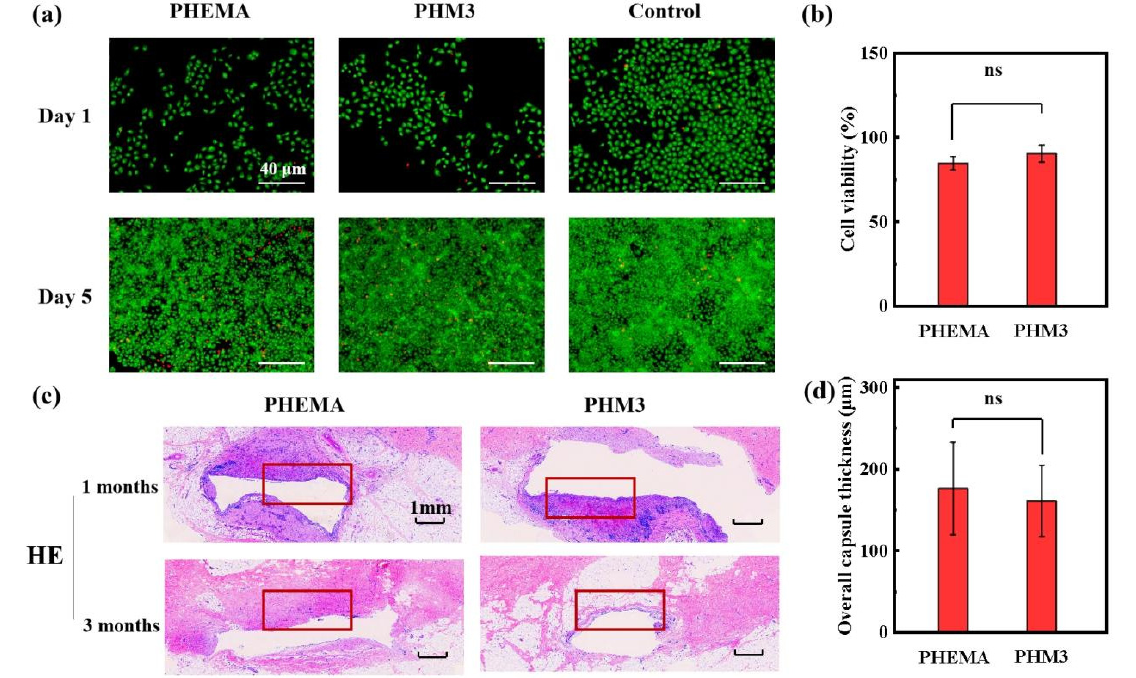
Figure 5. Biocompatibility of the hydrogels. ( a ) Representative fluorescence images of the PHEMA and PHM3 hydrogels after 1 and 5 days of cell culture. ( b ) Cell viability determined by the CCK method after 24 h. ( c ) Representative images of histological sections of explants implanted subcutaneously in swine for 1 and 3 months with H&E staining (the red rectangle indicates the capsule). ( d ) Overall capsule thickness of the PHEMA and PHM3 hydrogel samples implanted for 3 months (NS represents no significant difference).